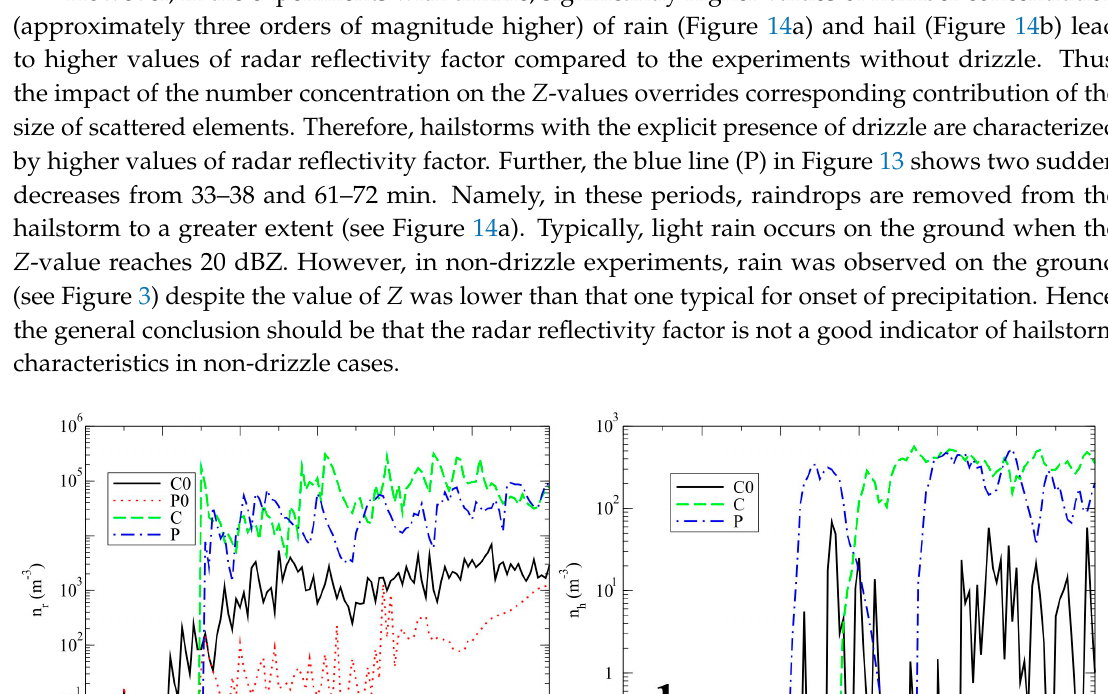
Figure 15. Horizontal distribution of convective available potential energy ( CAPE ) at t = 120 min for the non-drizzle and drizzle cases. Isolines are drawn in intervals of 300 J kg − 1 ; the base isoline is 0 J kg − 1 . The values of CAPE are depicted using a scale on the right-hand side of the figure. A non-shaded areas represent the value of 0 J kg − 1 .